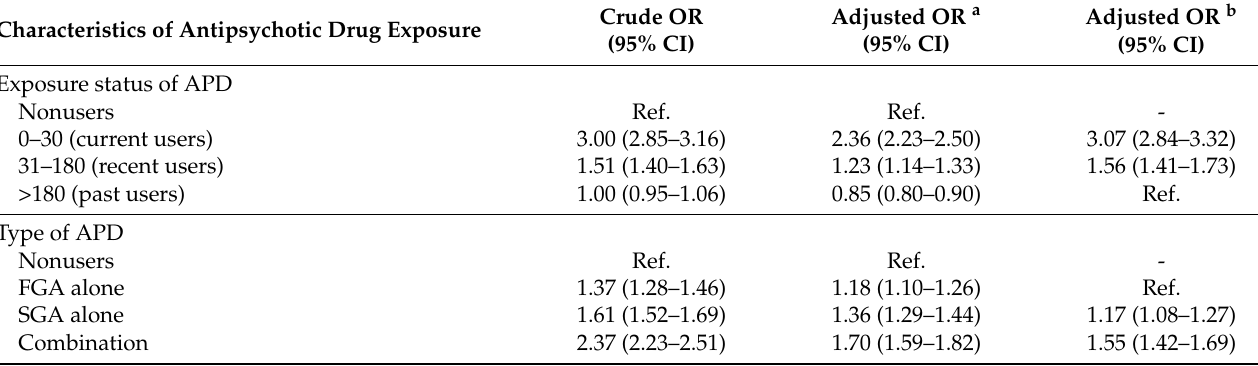
Table 3. The risk of hip fracture according to different characteristics of antipsychotic drug exposure. Characteristics of Antipsychotic Drug